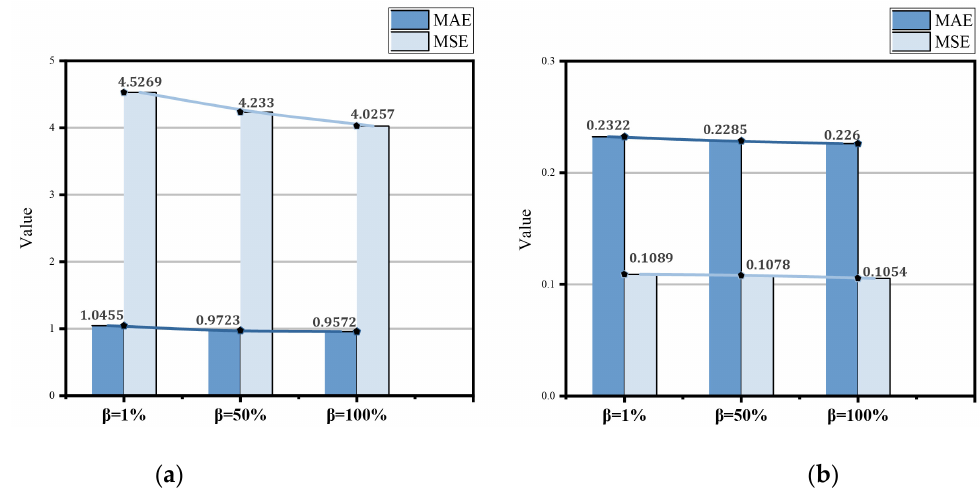
Figure 5. ( a ) describes the performance indicators on the Trento dataset; ( b ) describes the performance indicators on the Milano dataset.